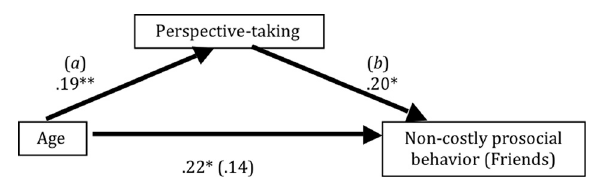
FIGURE 5 | Perspective-taking skills mediating the link between age and prosocial behavior. Figure depicts the results of the mediation analyses and shows that perspective-taking is a mediator between age and non-costly prosocial behavior toward friends. ∗∗ p < 0 . 001, ∗ p < 0 .